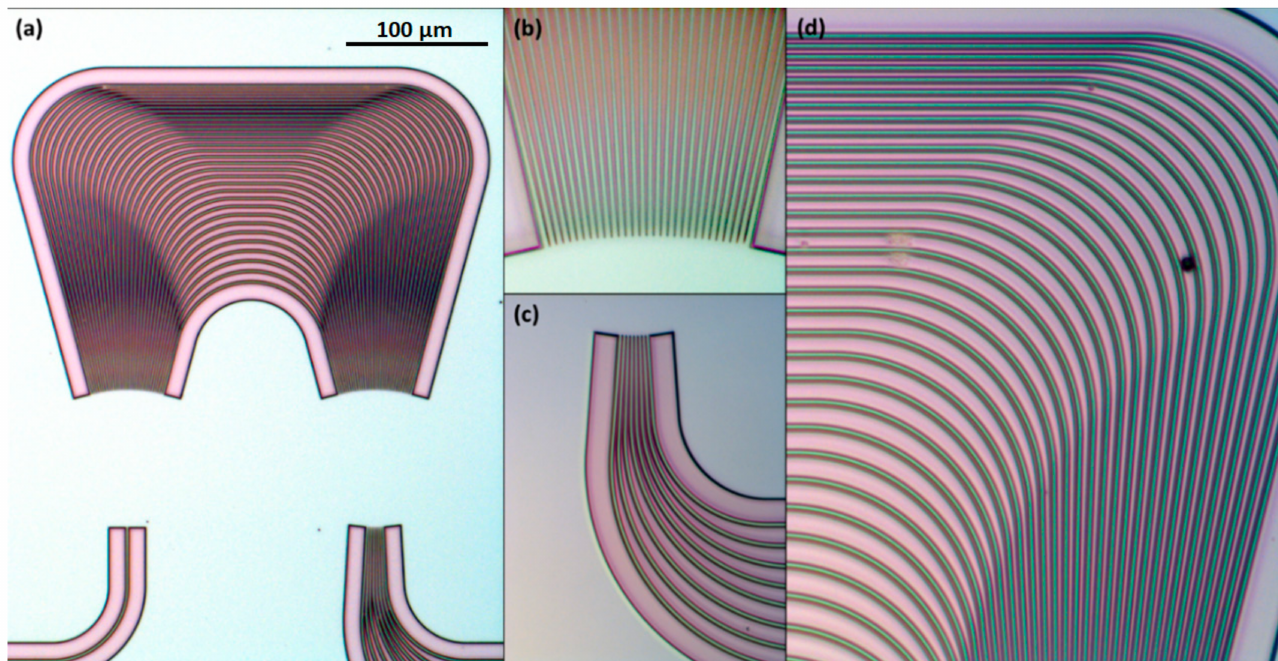
Figure 18. Microscope images of final structures: ( a ) AWG 100 GHz 1 × 8 designed for λ c = 610 nm; ( b ) a detail output aperture; ( c ) detailed image plane; and ( d ) detailed